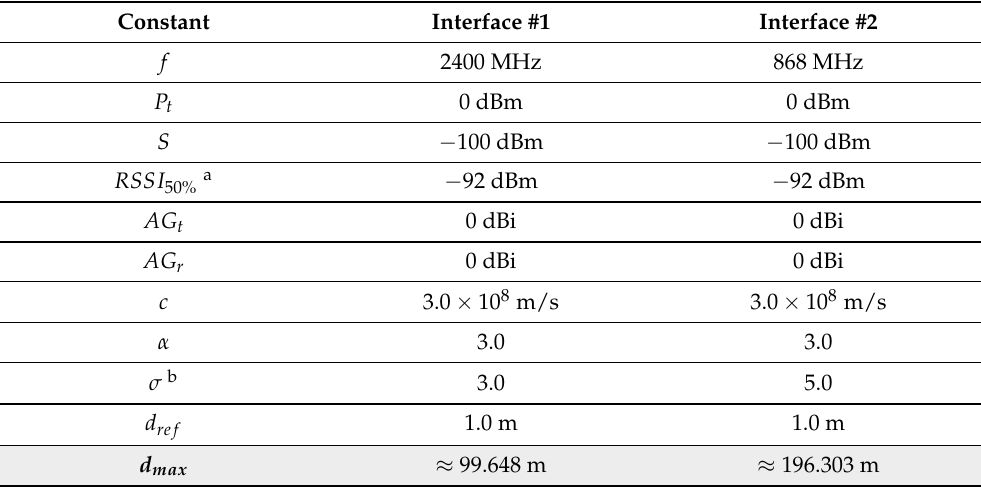
Table 2. Overview of the constants used to configure the log-distance path loss model (with log- normal shadowing) in our simulations.